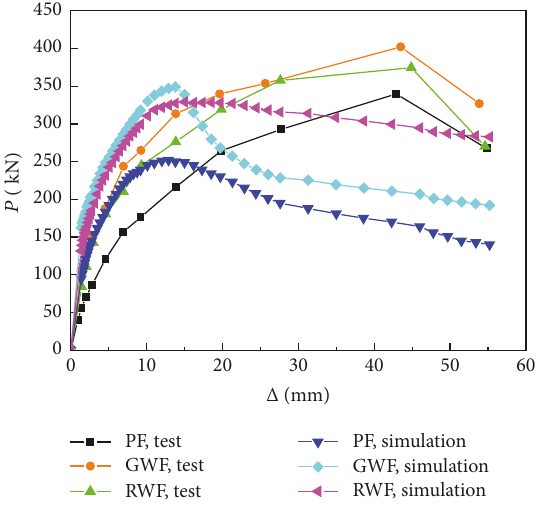
Figure 13: Load-displacement skeleton